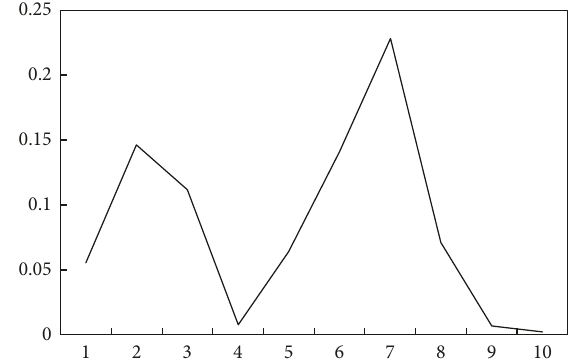
Figure 10: Grey condense spectrum of AQI and housing